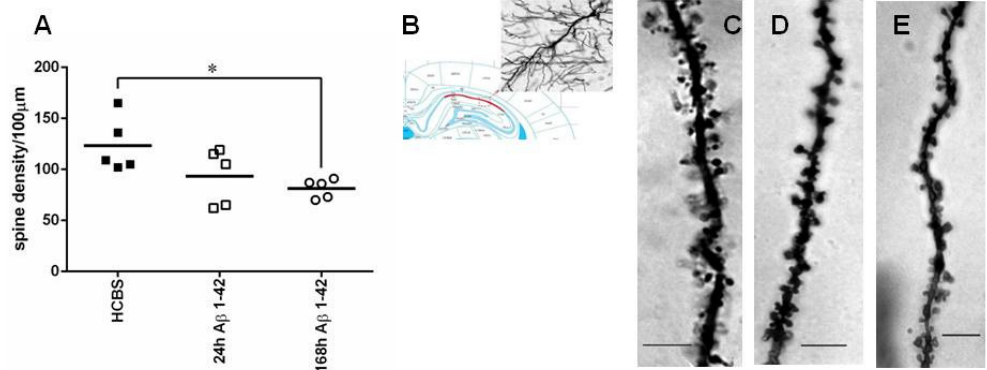
Figure 6. Representative examples of hippocampcal sections stained with Golgi-Cox method to show the presence of the prevailing changes in spine density after treatment with 24 h or 168 h aggregated A β 1-42 (24 h/25 μ M and 168 h/25 μ M). ( A ): apical dendritic spine density. Each dot represents the counted raw data, while horizontal bars indicate mean values. Significant difference in spine densities was observed between HCBS and 168 h aggregated oA β 1-42 treated groups ( p = 0.048, n = 2, 2–2 slices per group and 3–3 neurons per slice; n refers to the number of animals per group). Statistical significance was determined by one-way ANOVA, followed by a Games Howell post hoc test. * Differences with a p -value < 0.05 were considered significant; ( B ): 20× magnification of a CA1 subfield pyramidal neuron; ( C ): control (HCBS) group; ( D ): 24 h aggregated 25 μ M A β 1-42 treated group; ( E ): 168 h aggregated 25 μ M A β 1-42 treated group. Scale bar: 10 μ m.